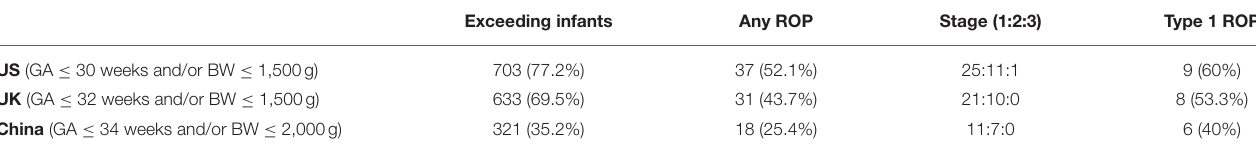
TABLE 4 | Numbers of infants exceeding the screening guidelines of the US, UK, and China and the ROP patients who may be missed. Exceeding infants Any ROP Stage